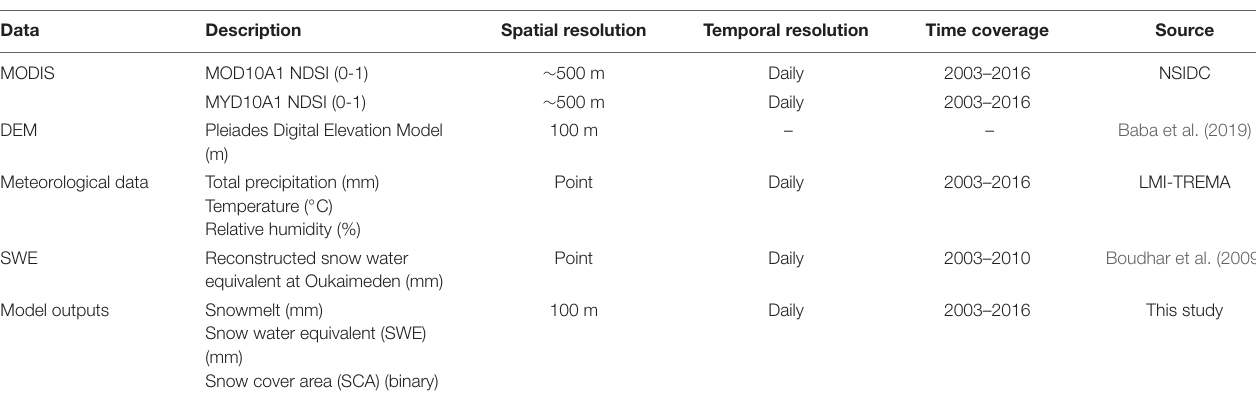
TABLE 1 | Data used in the current